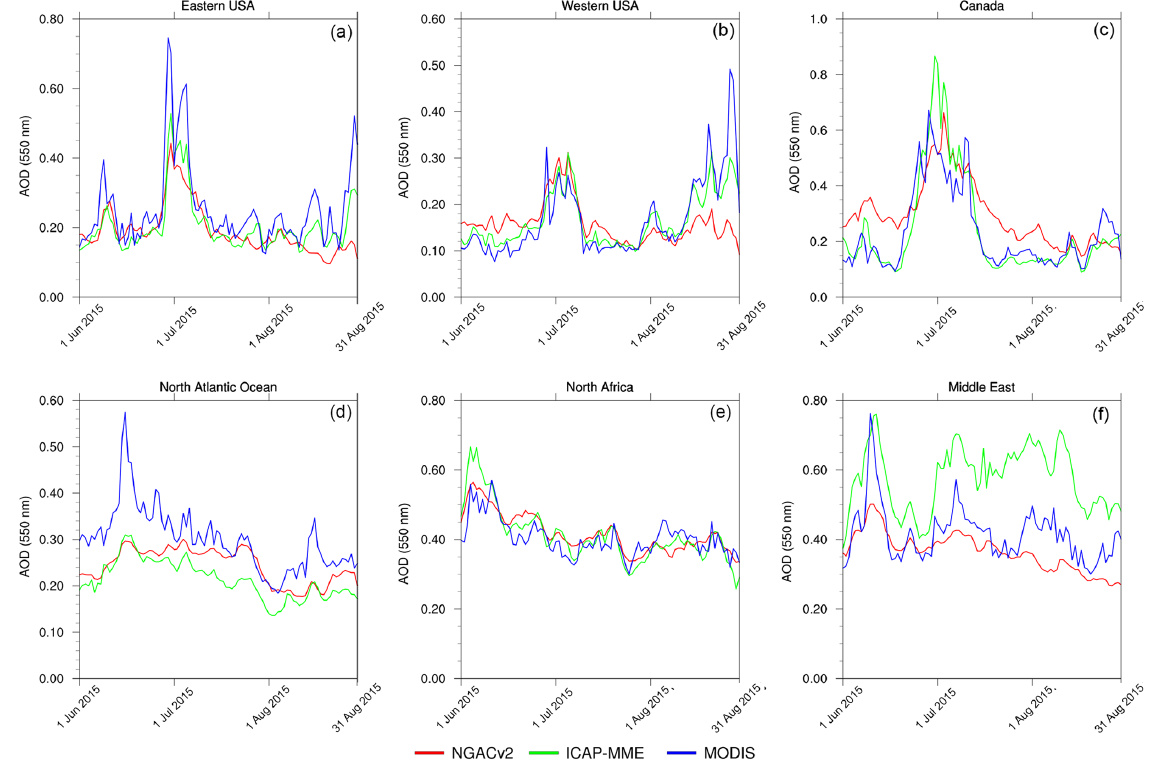
Figure 4. Regional time series comparison of daily modeled and satellite-retrieved AOT between 1 June and 31 August 2015 over selected regions (a–f) . See Table 1 for description of the regions. Points over the ocean are masked for calculating AOT over land-only regions and vice